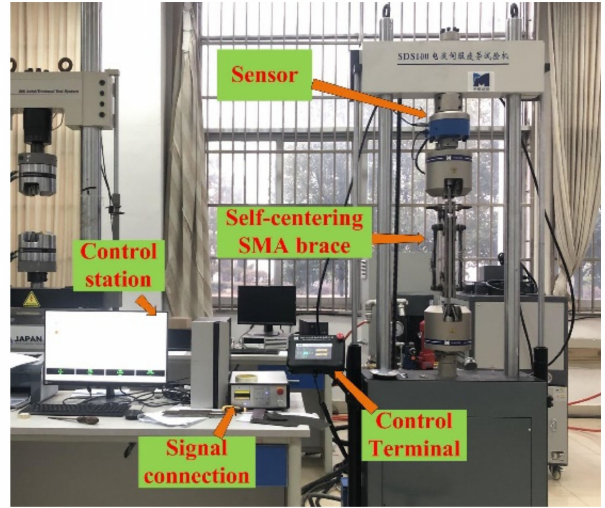
Figure 6. Diagram of the experimental